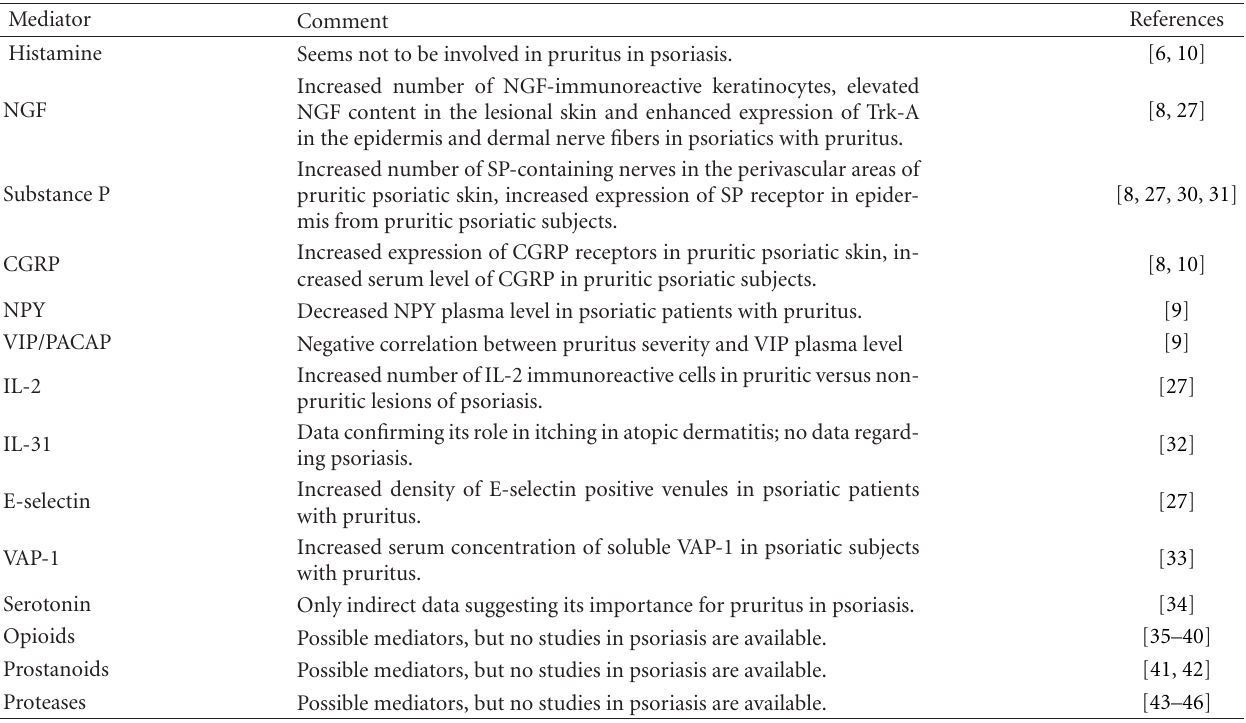
Table 1: Possible mediators involved in itching in